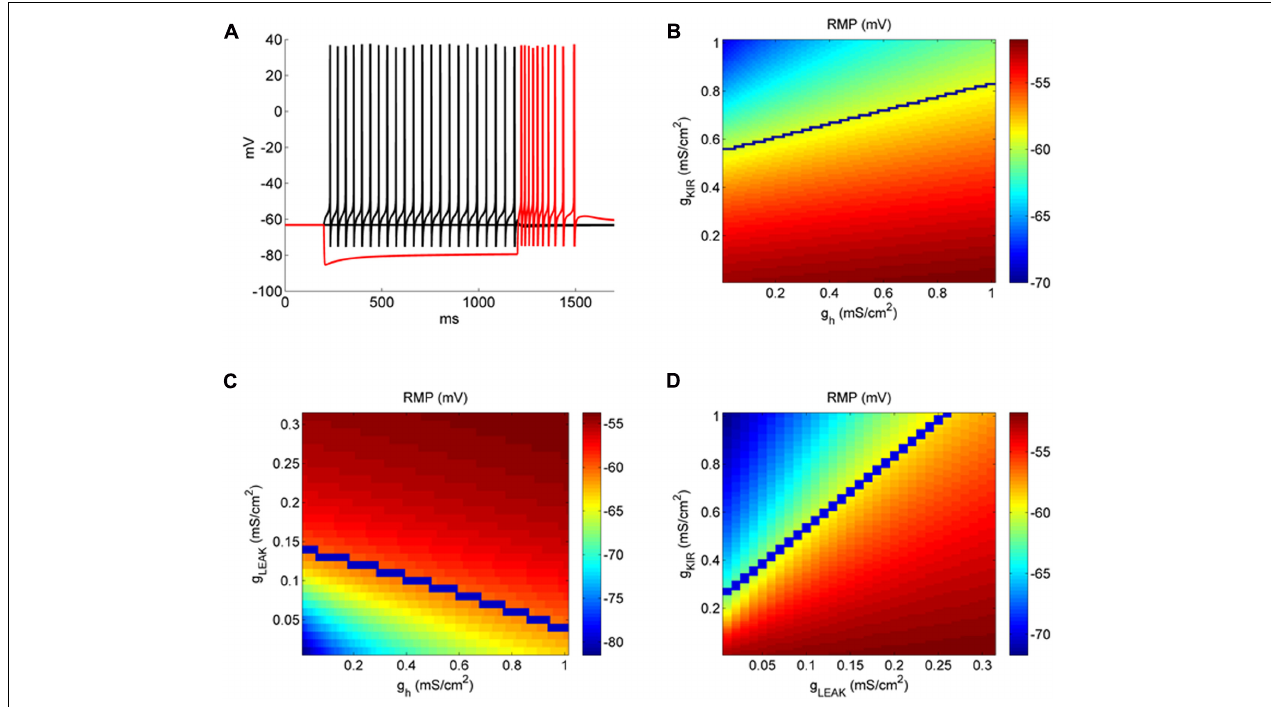
FIGURE 6 | I Kir affects more RMP than I h in a model of DCN fusiform neuron. (A) Example of the behavior of the fusiform neuron model to membrane hyperpolarization and depolarization. (B) Conductance space of g h versus g Kir affecting RMP (color coded). The blue line represents the transition from quiet (above) to active (below) firing modes. (C) Conductance space of g Leak versus g h affecting RMP (color coded). The blue line represents the transition from quiet (above) to active (below) firing modes. (D) Conductance space of g Kir versus g Leak affecting RMP (color coded). The blue line represents the transition from quiet (above) to active (below) firing